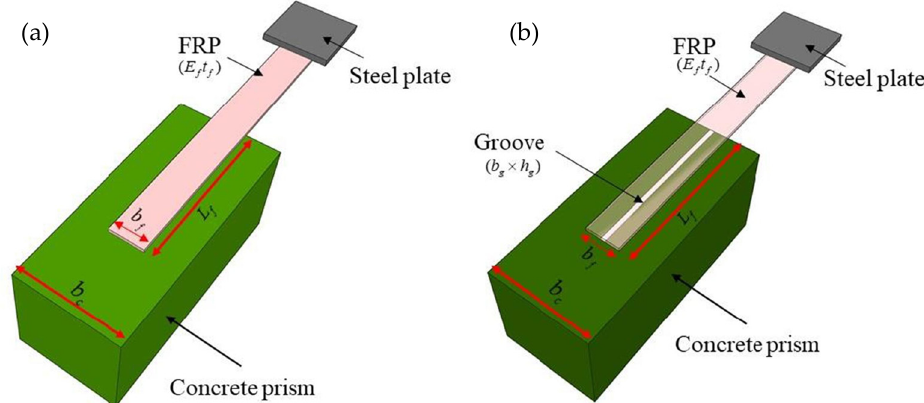
Figure 1. Schematic diagram of a single-lap shear test to compute the interfacial bond strength such that: ( a ) FRP is externally bonded on concrete without groove, and ( b ) FRP is externally attached to the concrete with groove [2].